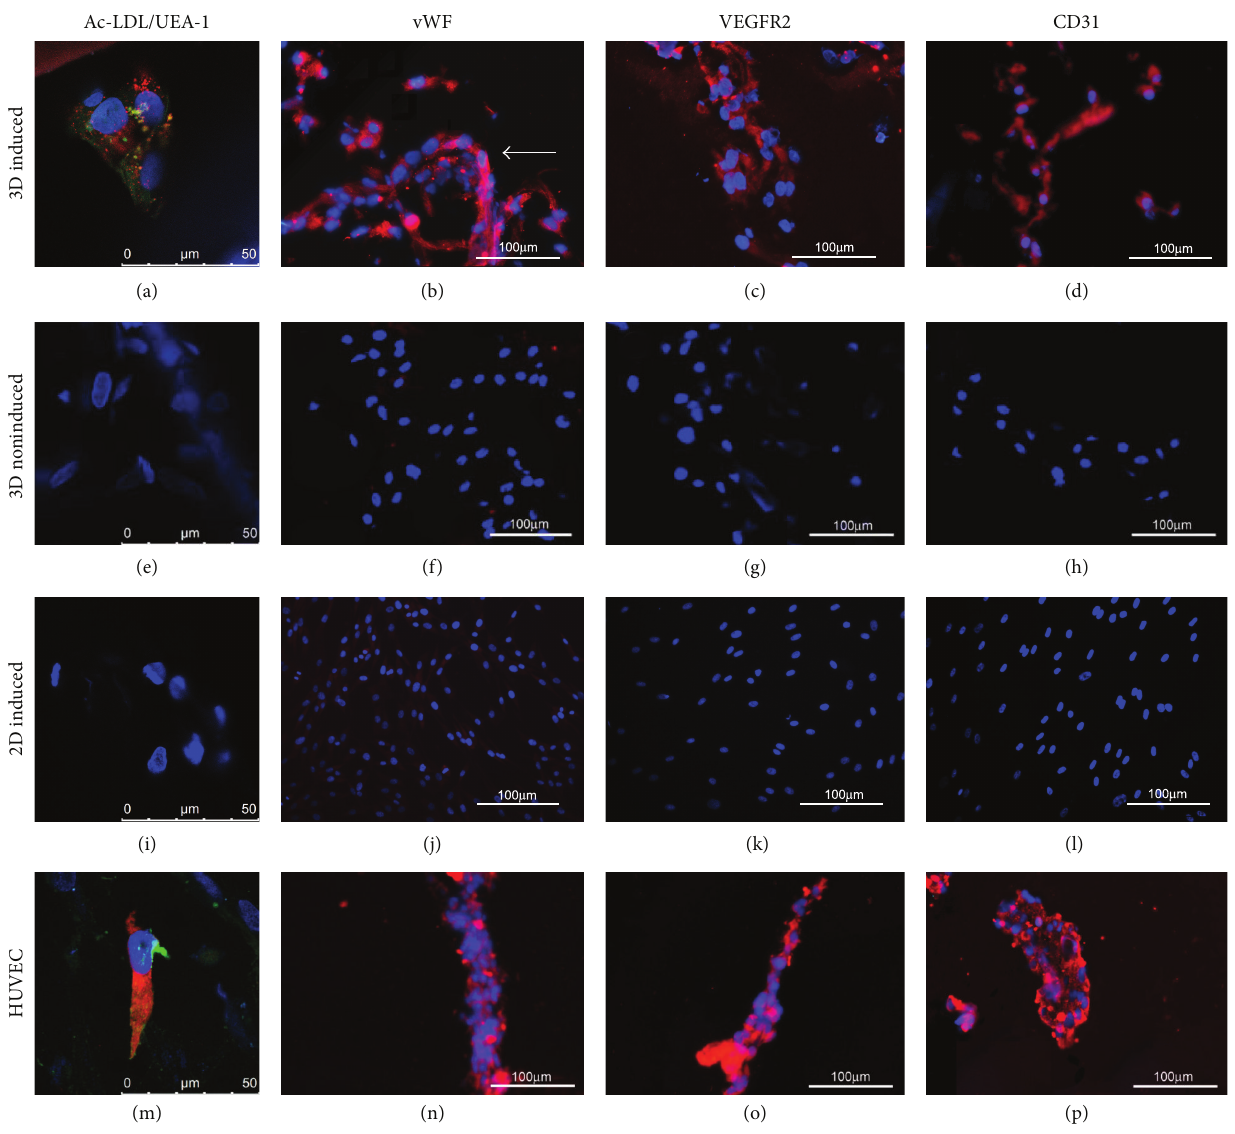
Figure 4: Endothelial phenotype in 2D/3D cultured hADSCs after 21 days. Uptake of Ac-LDL/UEA-1 in the 3D induced hADSCs (a), 3D noninduced hADSCs (e), 2D induced hADSCs (i), and HUEVC (m) at 21 days in vitro examined by laser confocal microscopy (scale bars: 50 𝜇 m). Immunofluorescence stainings of endothelial markers of vWF ((b), (f), (j), and (n)), VEGFR2 ((c), (g), (k), and (o)), and CD31 ((d), (h), (l), and (p)) in the 3D induced hADSCs, 3D noninduced hADSCs, 2D induced hADSCs, and HUVEC (scale bars: 100 𝜇